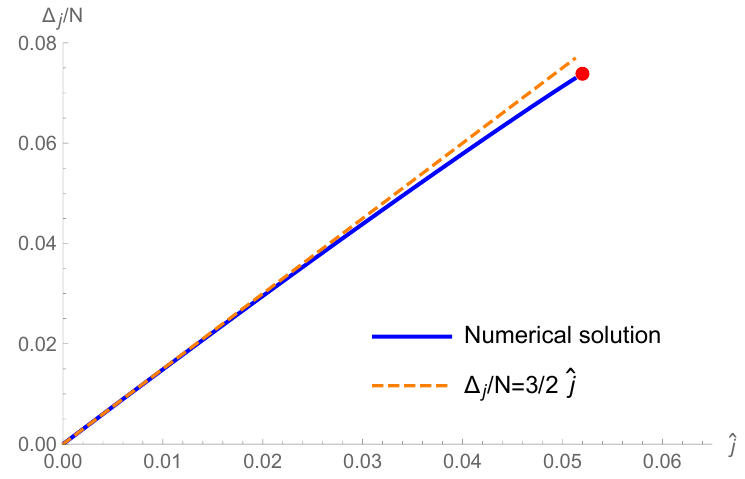
Figure 3 . Scaling dimension in d = 5 as a function of ˆ j = j/N . The solid line corresponds to the numerical solution of the saddle point equation, and the dashed line to the small ˆ j approximation ˆ j . the red dot corresponds to the critical values ˆ j ∆ j = 3 N 2 scaling dimension becomes complex for ˆ j > ˆ j crit ’ 0 . 052 .